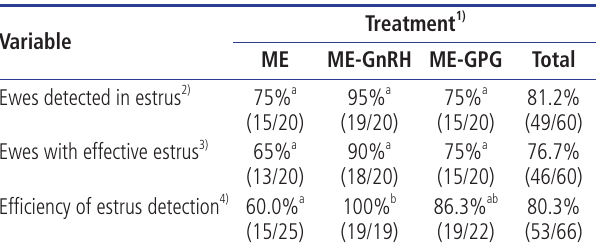
Table 3. Percent of ewes detected in estrus, percent of ewes served during the 36-d breeding period, and efficiency of estrus detection after anestrous Suffolk ewes were exposed to different treatments in the second experiment